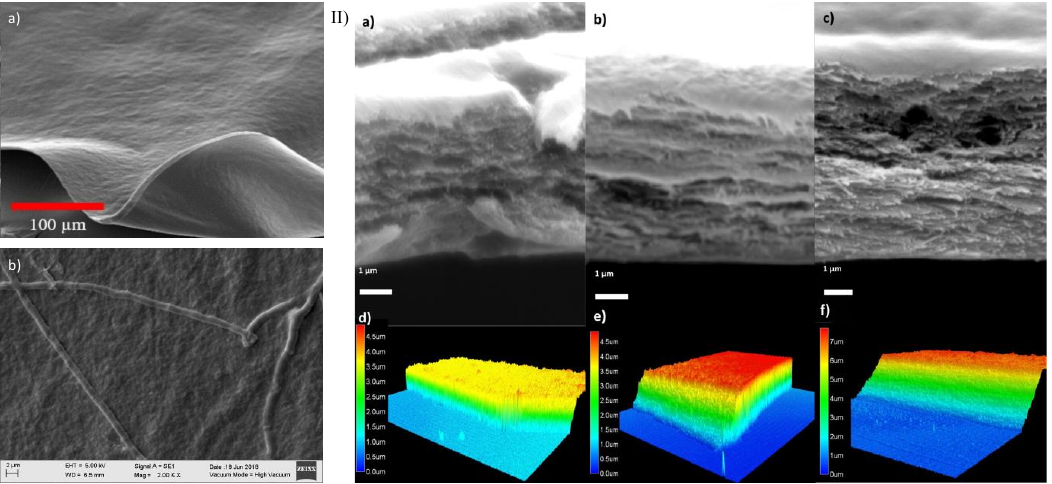
Figure 4. Representative surface and thickness evaluation using material confocal microscopy. Panel I ( a ) Surface micrograph of a 37-day desiccated 1X membrane. ( b ) Collagen fiber on the surface of a 1X CVM at day 7 of desiccation. Panel II: SEM transversal-view micrograph of a 1X (a), 2X (b), and 3X ( c ) CVM in wet conditions. ( d ) 1X, ( e ) 2X, and ( f ) 3X CVM showing a thickness of ~3.6, 4.8, and 7.2 μ m, respectively.